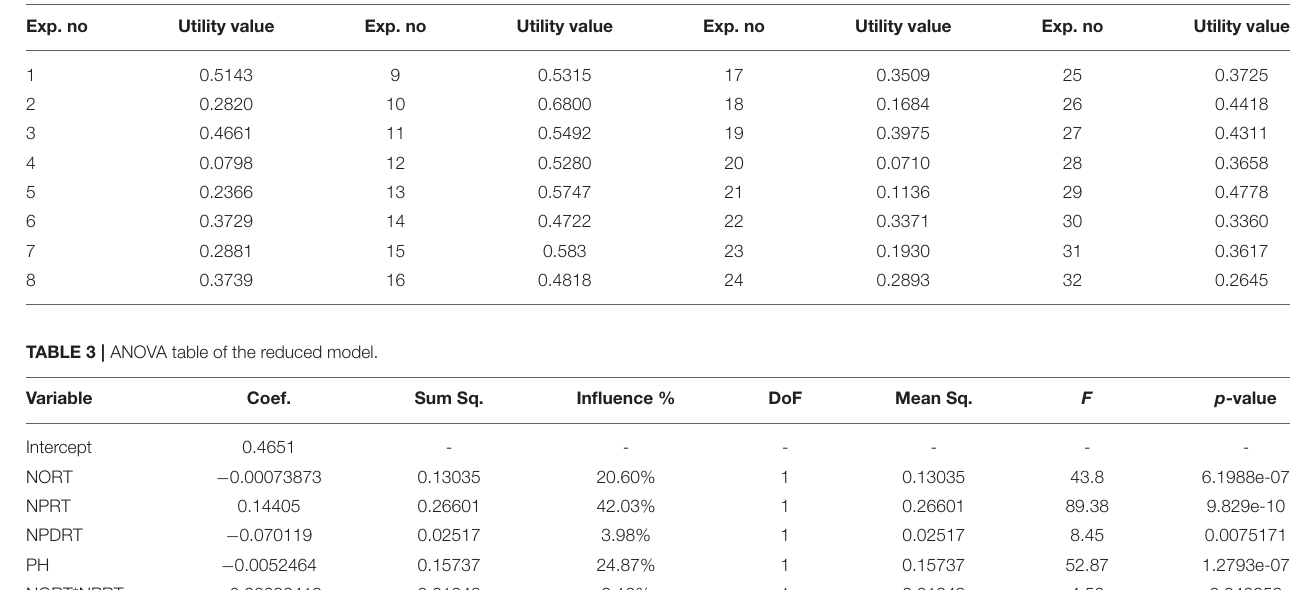
TABLE 2 | Design of experiments simulation results.